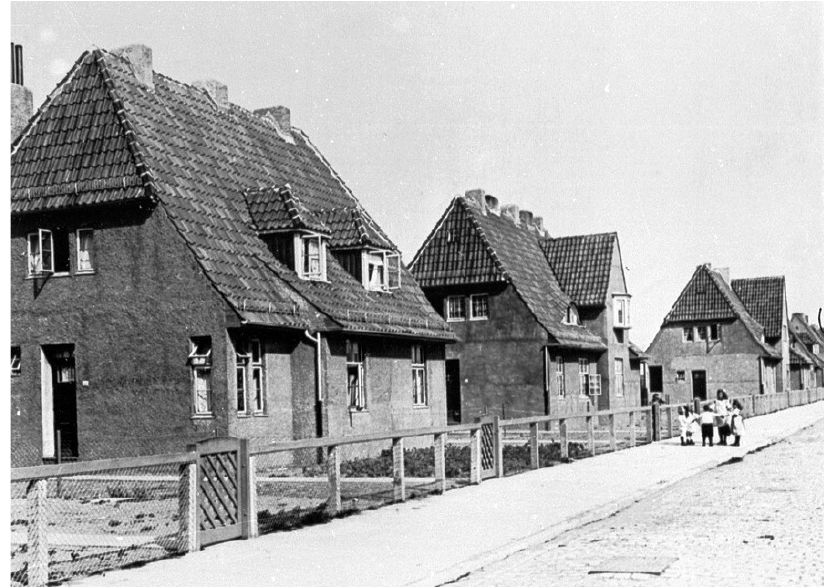
Figure 10. Wagner’s housing for workers in Burg‐Grambke, Bremen, 1910. From the collection of Franz Stoedtner. Source: “Arbeiterkolonie” [Workers’ Colony] (n.d.), © Bildarchiv Foto Marburg.